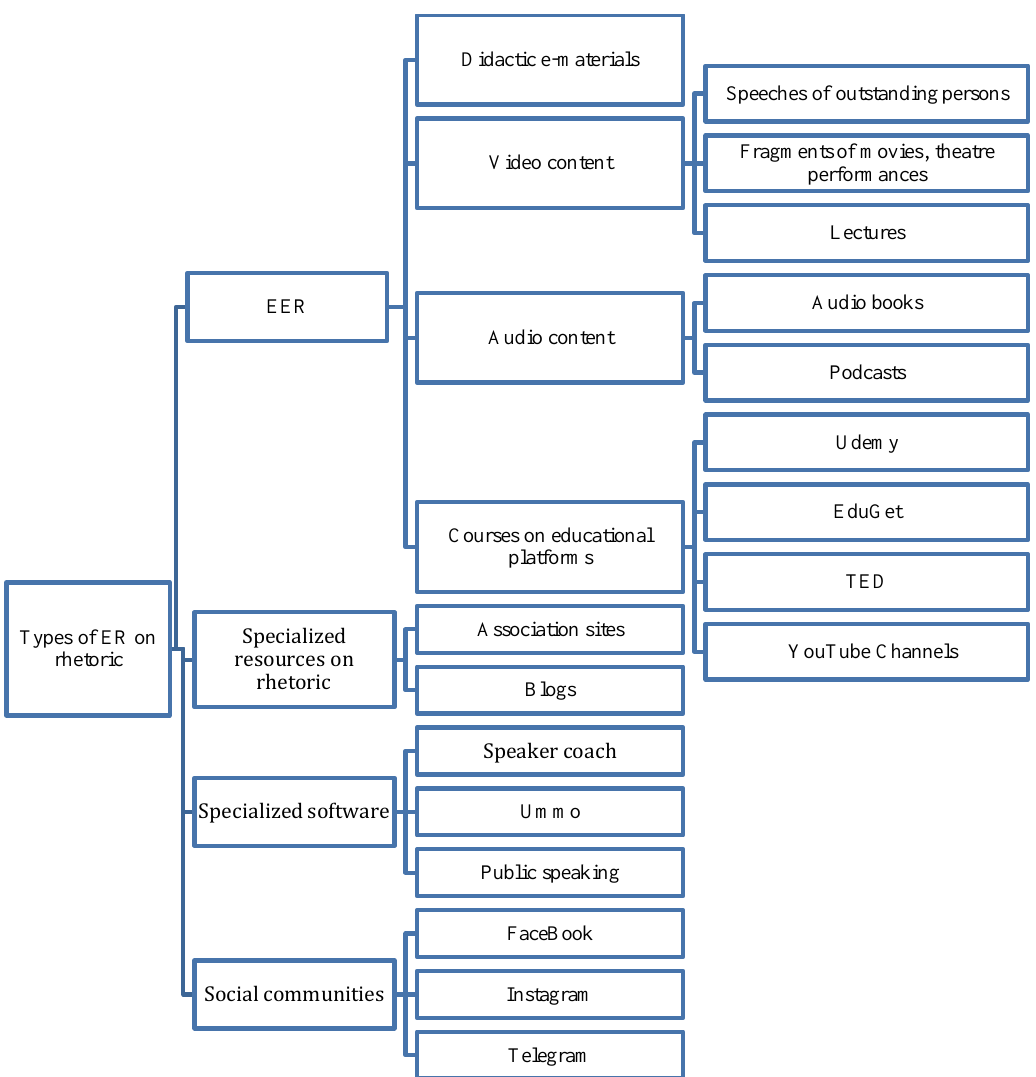
Figure 1: Educational e-resources on